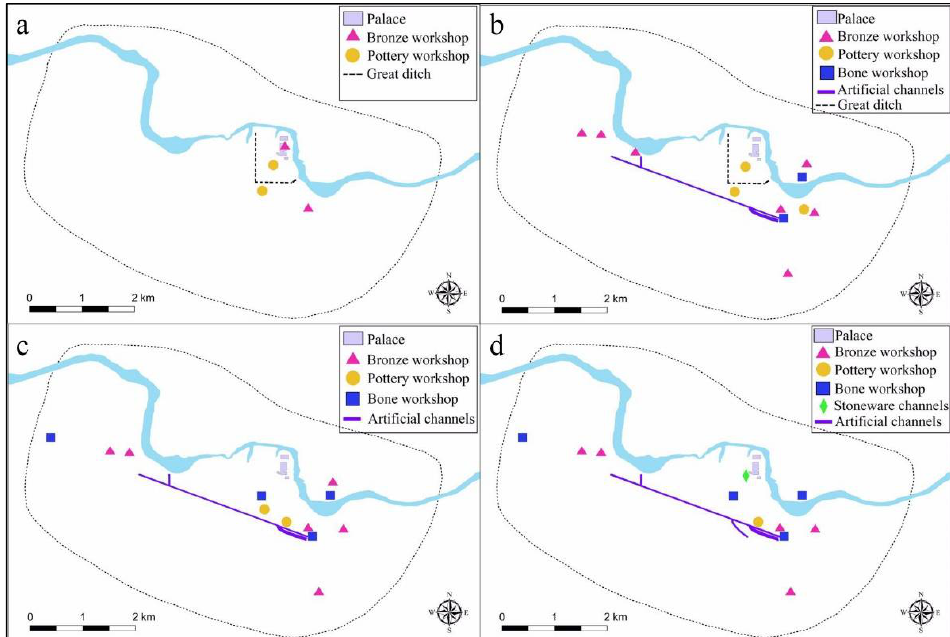
Figure 7. Distribution map of artificial channels and handicraft workshops at Yinxu in different phases: ( a ) First Phase; ( b ) Second Phase; ( c ) Third Phase; ( d ) Fourth Phase. Numbers and scales of handicraft workshops increased and expanded since the Second Phase with the construction of artificial channels.